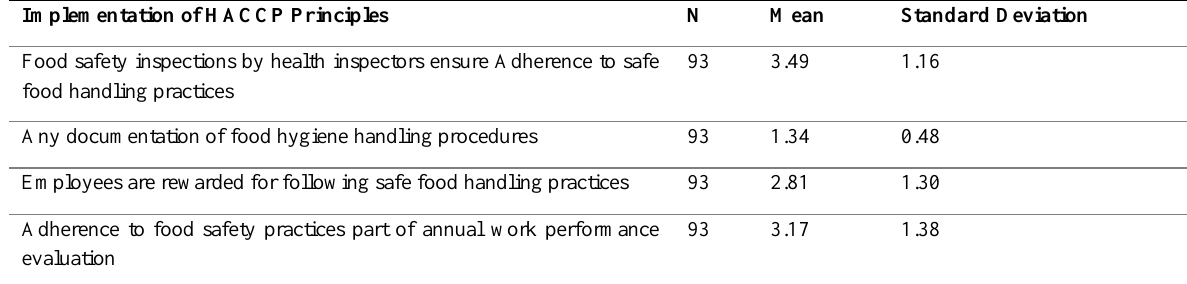
Table 3. Implementation of HACCP